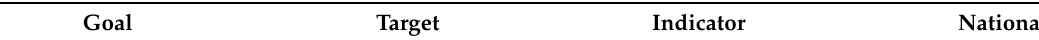
Table 3. Agenda 2030 indirect indicators to mobility